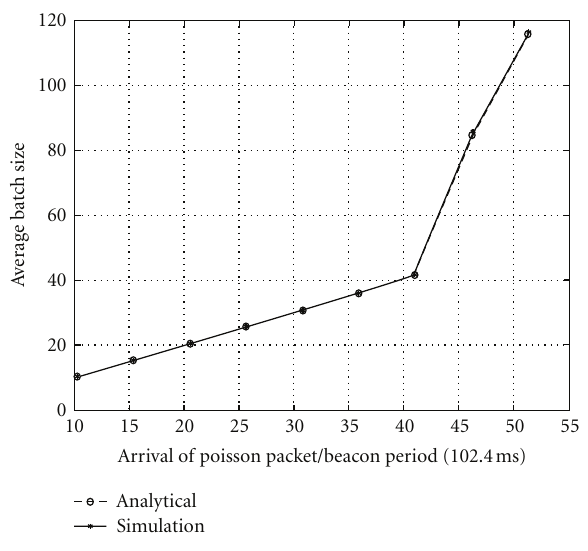
Figure 9: Average batch